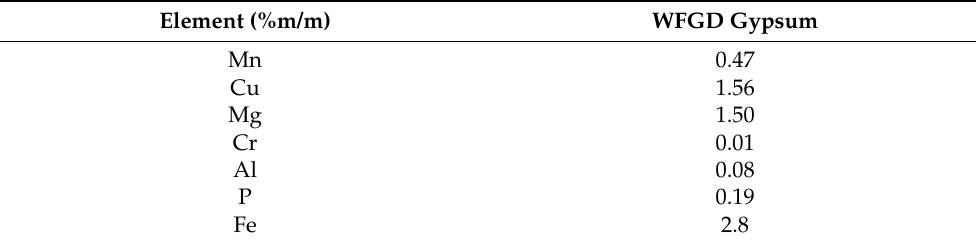
Table 2. Leachability of metals from the WFGD gypsum.